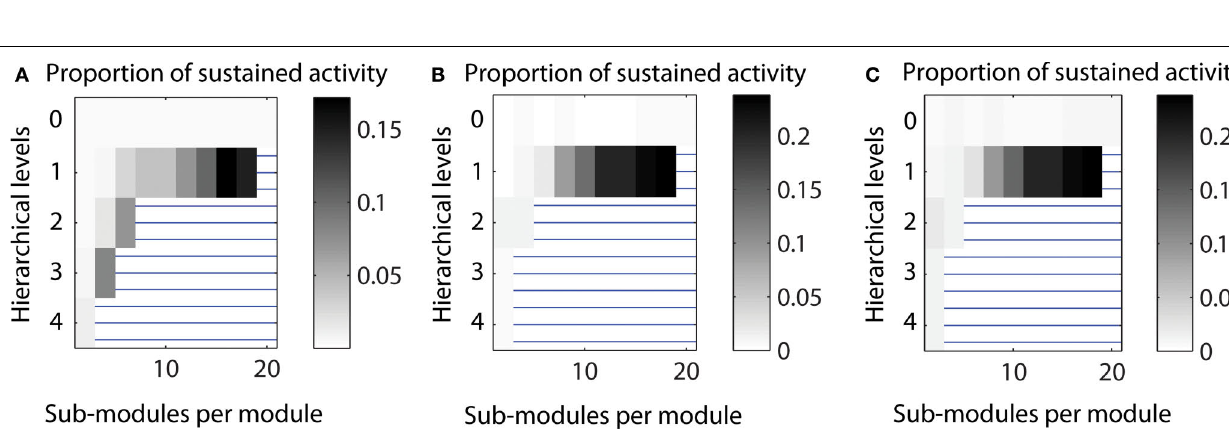
FIGURE 10 | Proportion of cases resulting in one of three scenarios of fi nal activity level. (A) Activity dying out. (B) Limited sustained activity. (C) Activity spreading through the network (above 50% activation threshold).